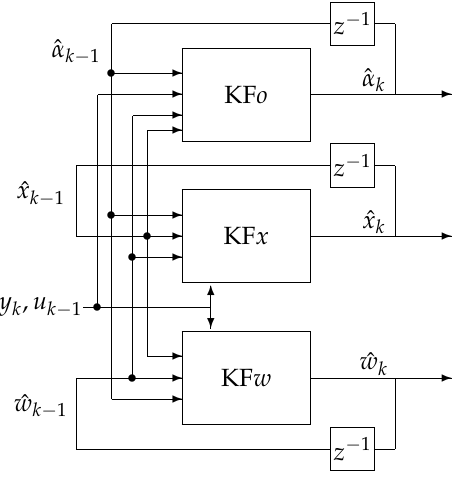
Figure 1. The Triple Estimation Algorithm